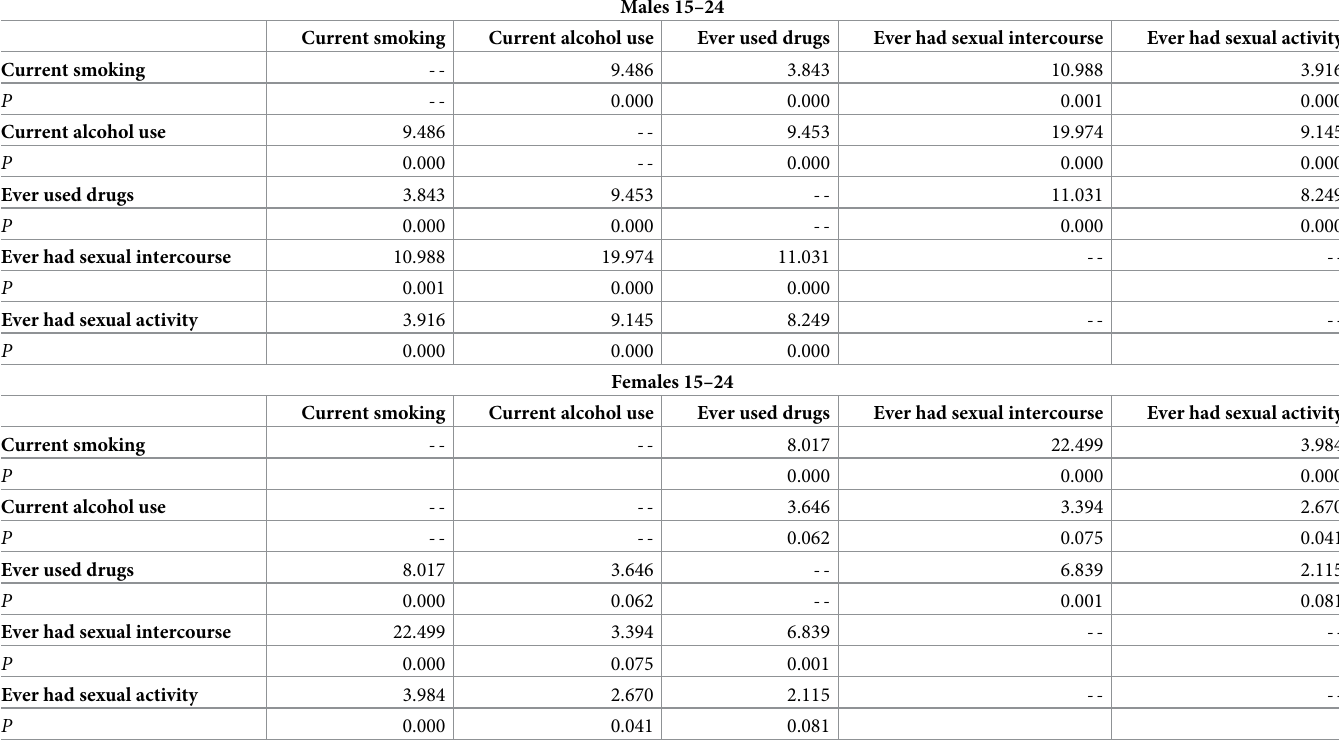
Table 4. Associations of individual risk behaviors (odds